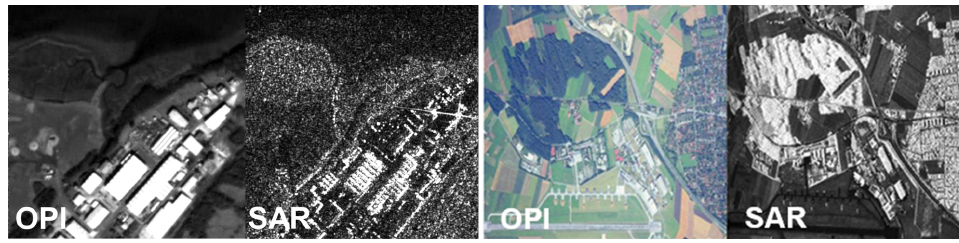
Figure 3. Comparison of SAR and OPI images